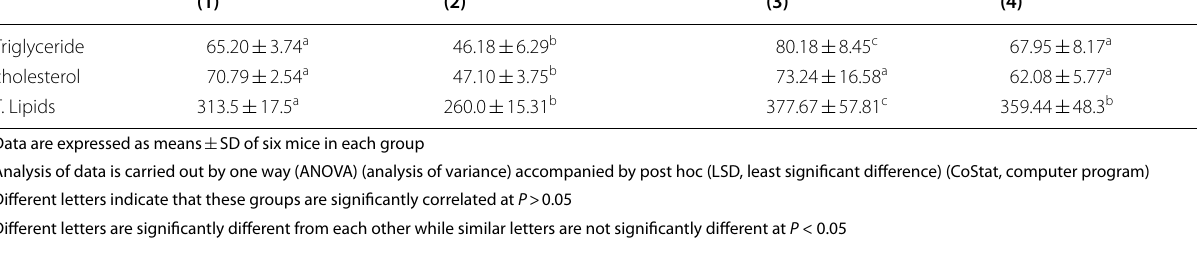
Table 5 Effect of T. viride F2 l ‑asparaginase on lipid peroxide and nitric oxide levels in serum of control and DENA‑intoxicated